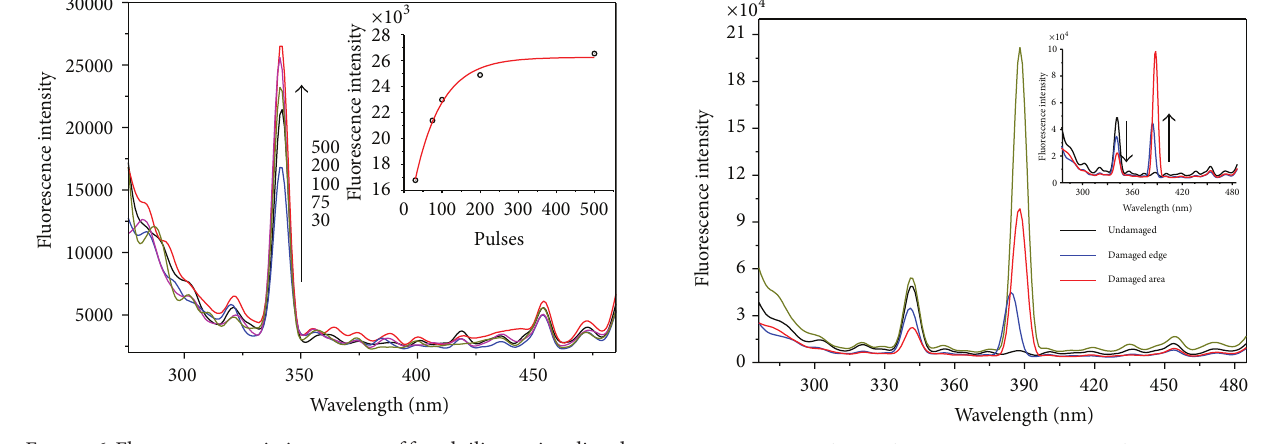
Figure6:Fluorescenceemissionspectraoffusedsilicapreirradiated in vacuum by different UV laser pulse numbers (30, 75, 100, 200, and 500); the pulse fluence is 8.16 J/cm 2 . Various fluorescence intensity at 335 nm irradiated by different pulse numbers in vacuum. Figure 7: Fluorescence emission spectra of laser damage crater